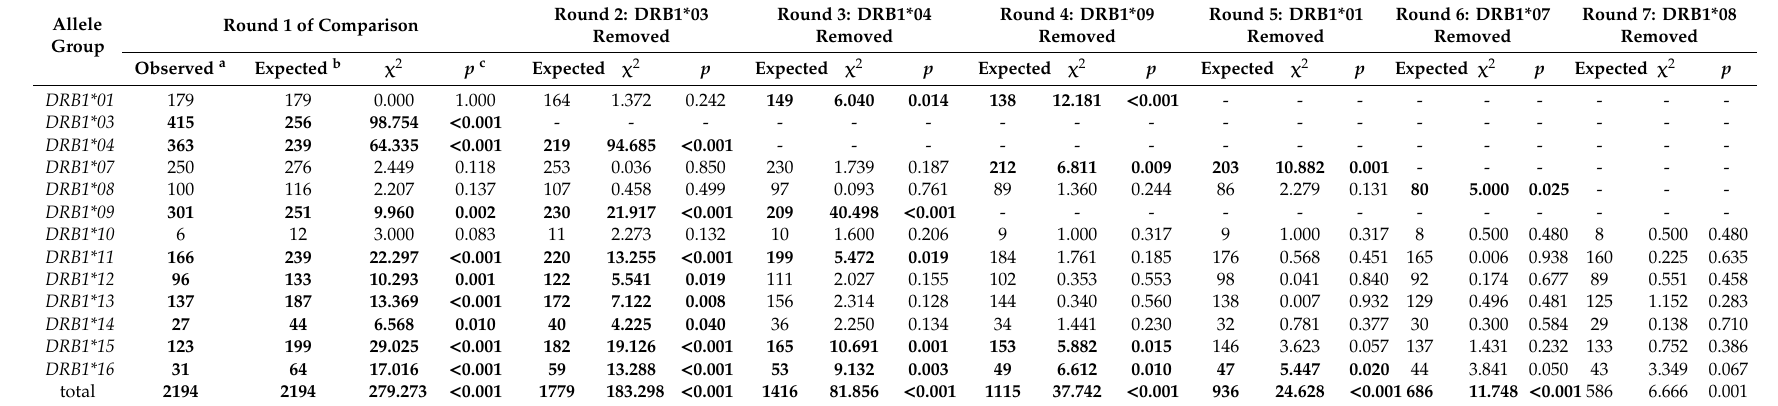
Table 7. RPEs of HLA-DRB1 allele groups on